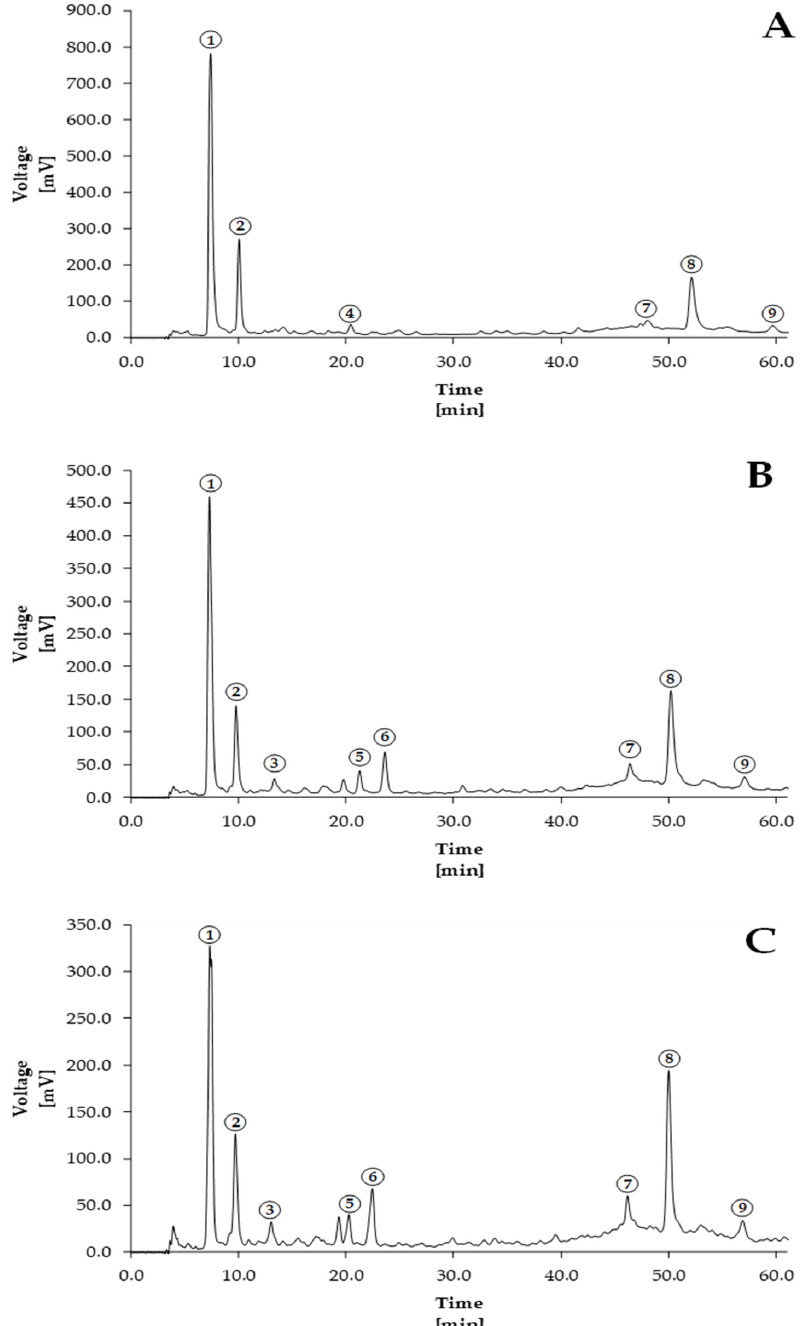
Figure 2. Chromatographic profile of the different table olive flours ( A ) Green; ( B ) Turning color; ( C ) Black, obtained by HPLC-DAD. The numbers correspond to the following compounds identified: 1—Hydroxytyrosol; 2—Tyrosol; 3—Chlorogenic acid; 4—Oleuropein derivative; 5—Verbascoside derivative; 6—Verbascoside; 7—Rutin; 8—Luteolin; 9—Apigenin.